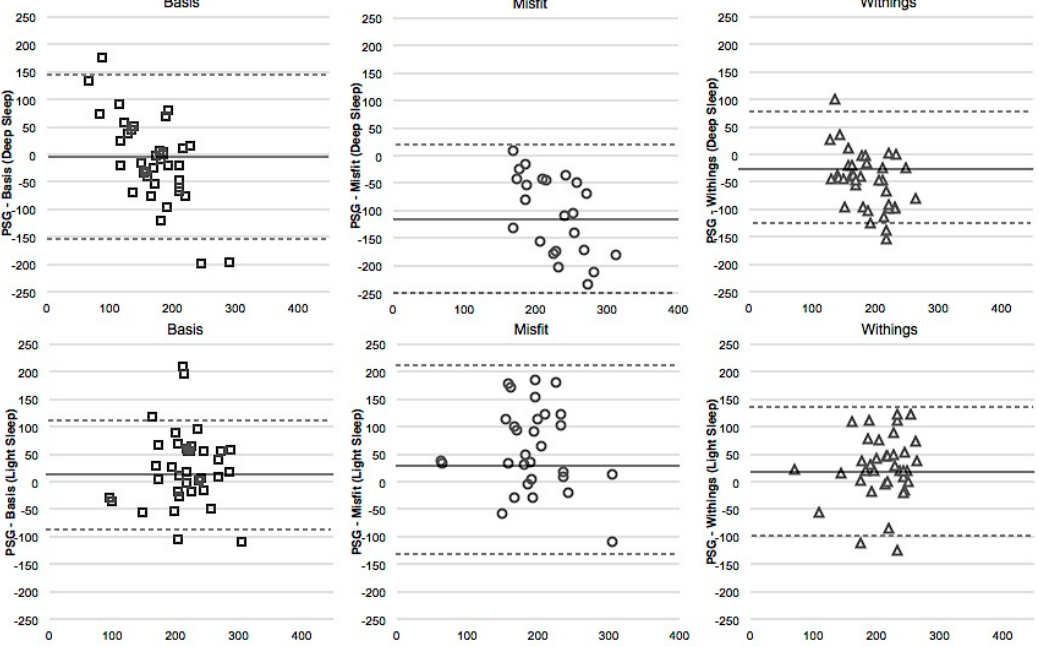
Figure 3. Bland-Altmann plots for Deep Sleep ( top row ) and Light Sleep ( bottom row ), each in minutes, for the Basis, the Misfit, and the Withings (adjusted values). The x-axis is the mean of the two devices, and the y-axis represents PSG minus the device. Dotted line represents two standard deviations from the mean.